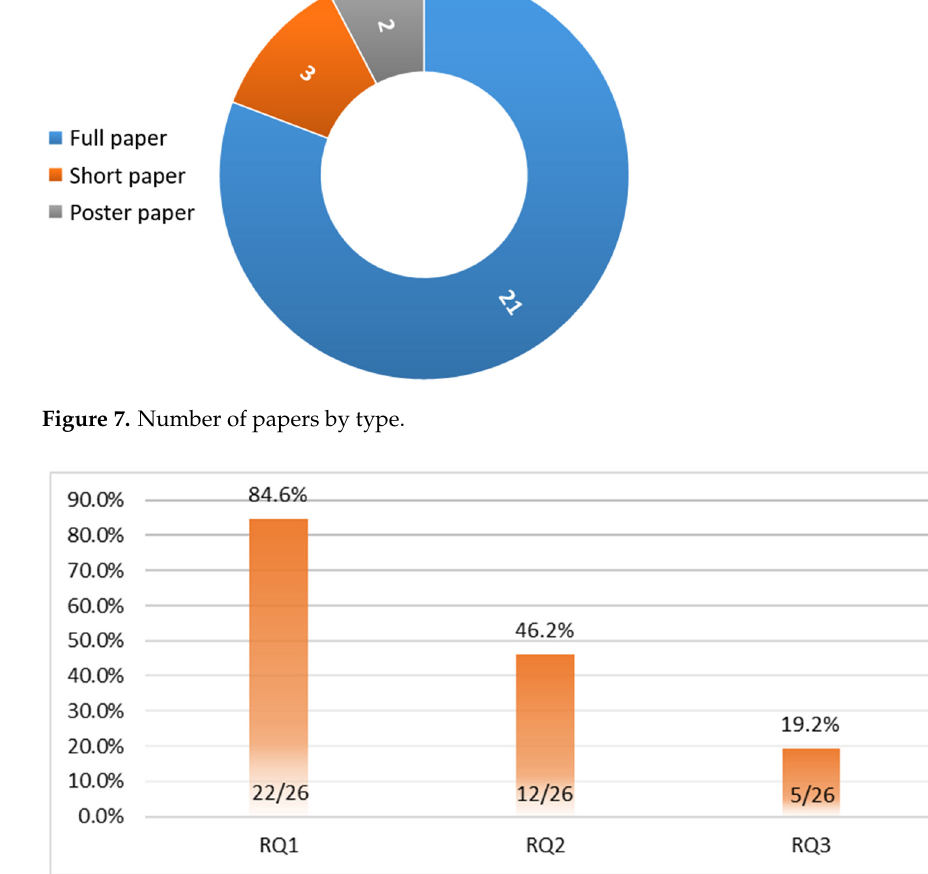
Figure 8. Percentage of selected studies that provided answers to the three research questions.